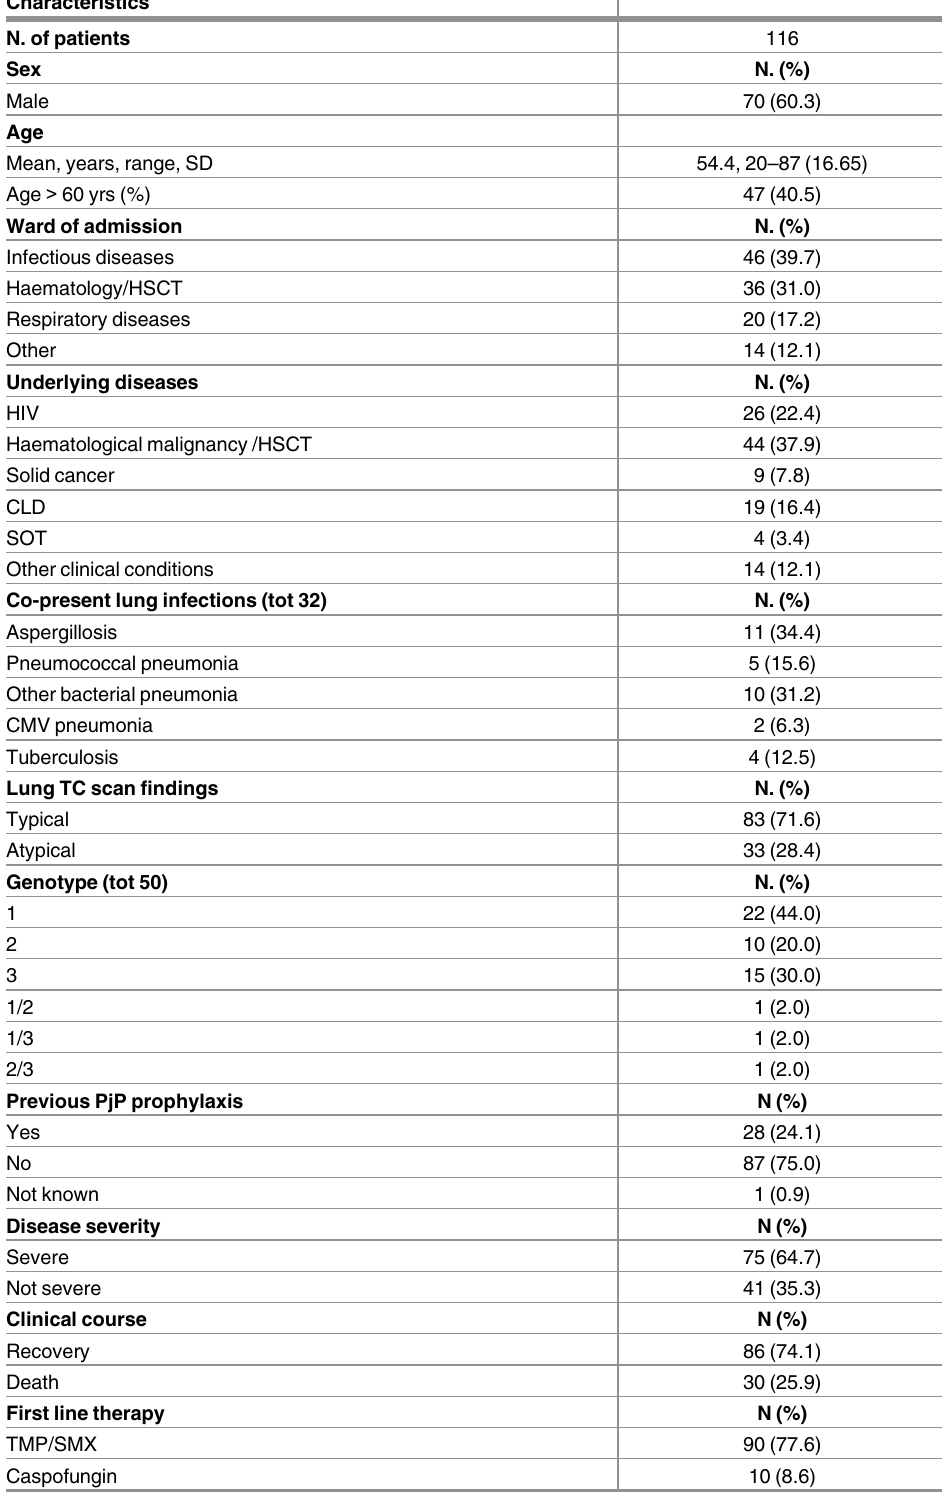
Table 1. General characteristics of 116 patients affected by PjP, patients’ number and percentage (%).